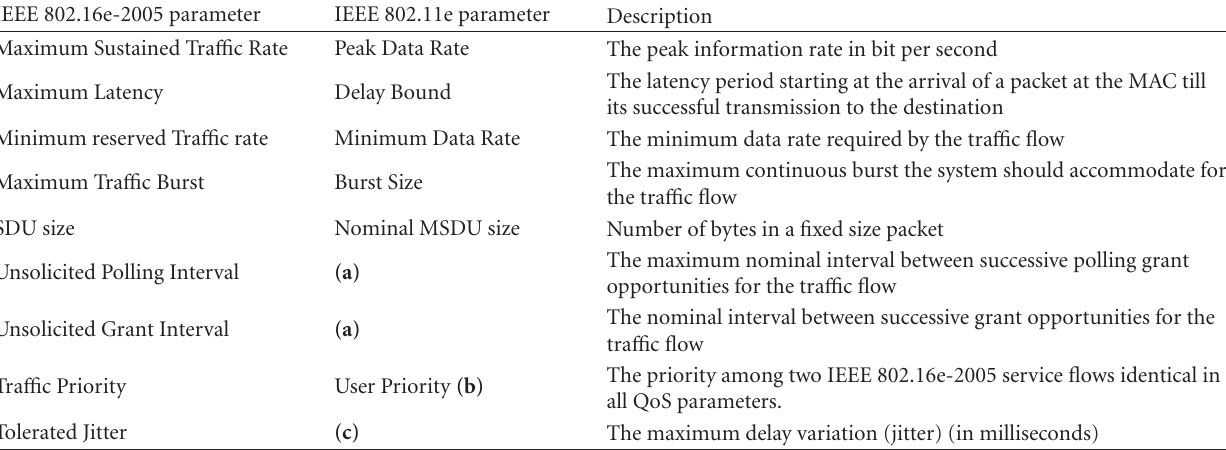
Table 3: QoS mapping between IEEE 802.11e and IEEE 802.16e-2005